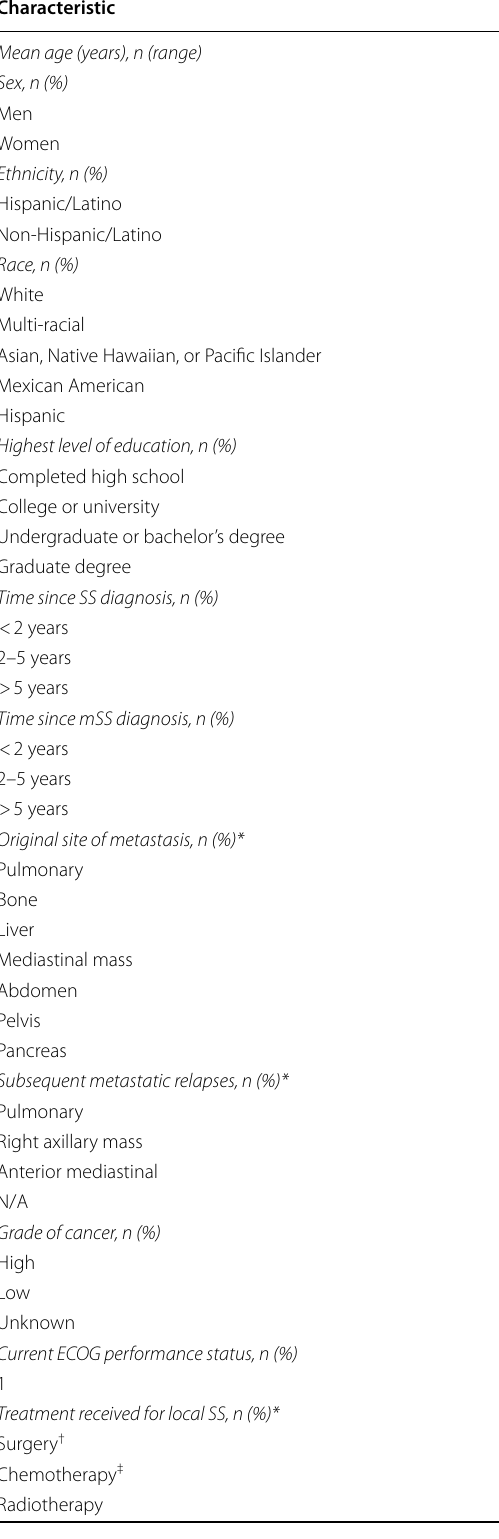
Table 3 Demographic and disease characteristics at time of